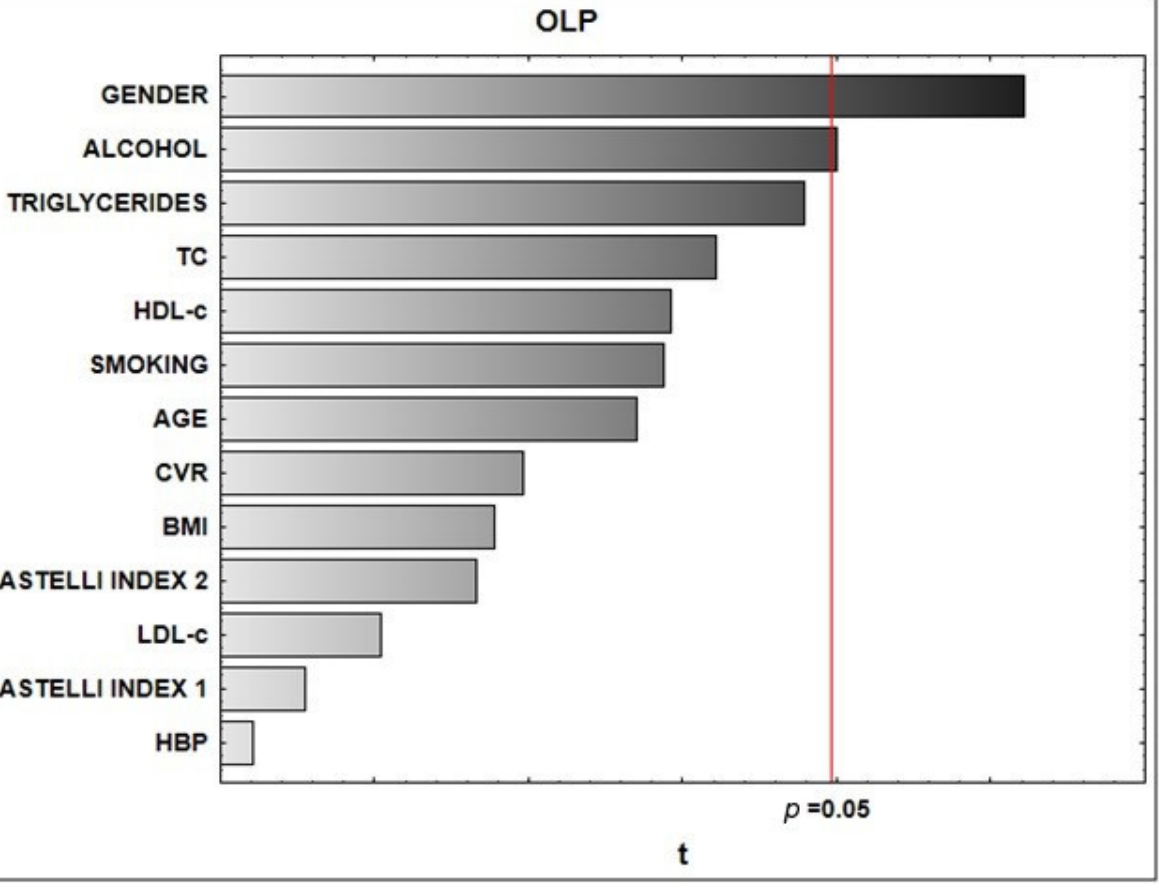
Figure 1. Correlations among the existence/absence of oral lichen planus (diagnosis) and chosen predictor variables.